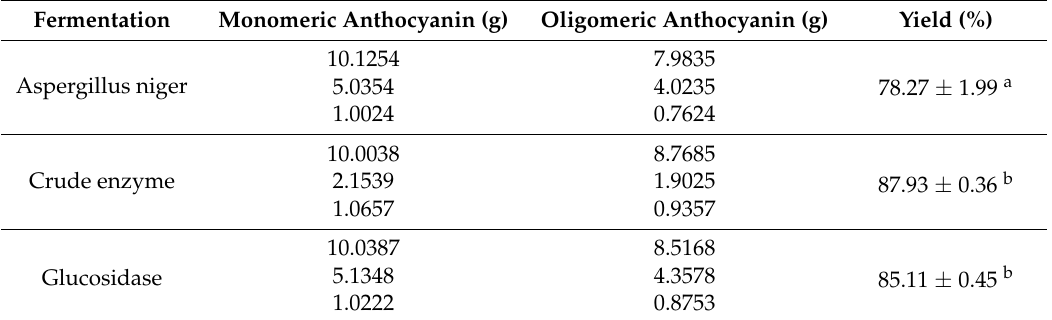
Table 1. The yield of oligomeric anthocyanins derived by fermentation as well as crude enzyme. Fermentation Monomeric Anthocyanin